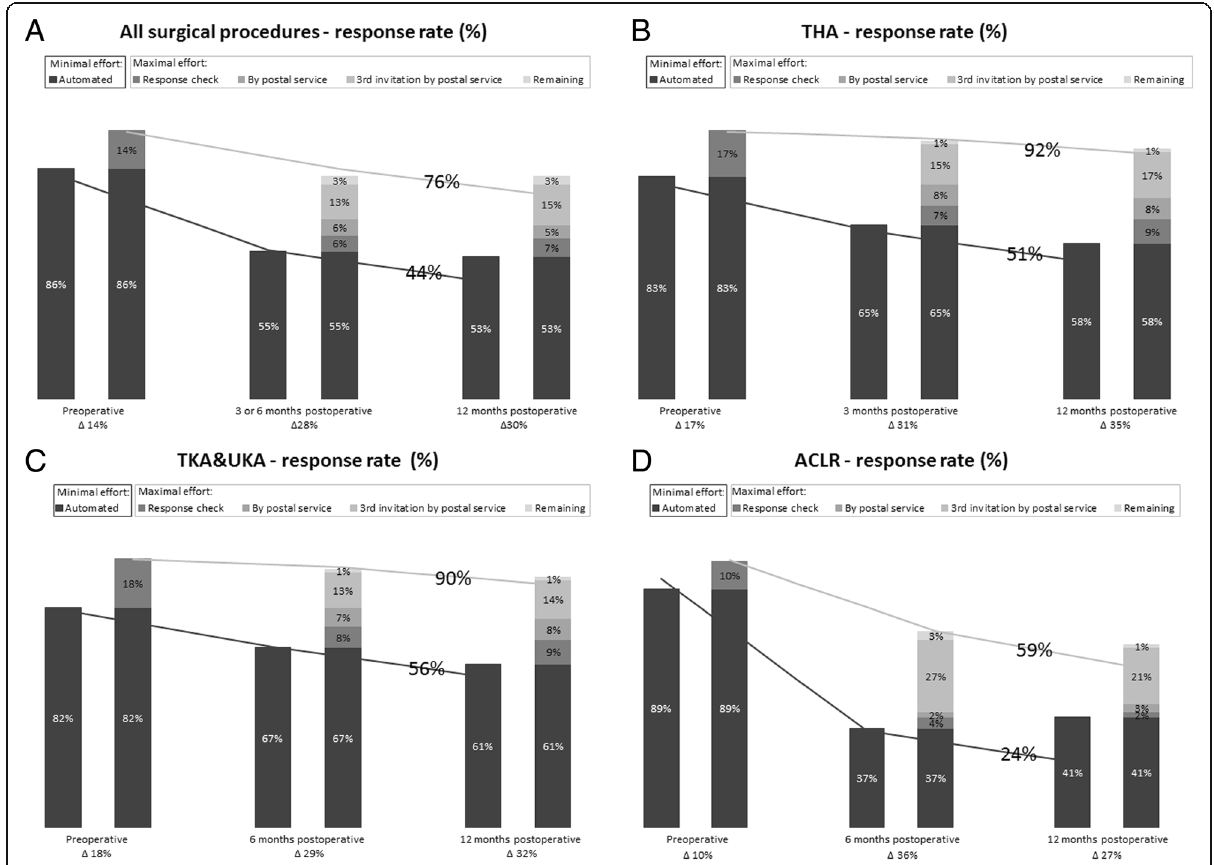
Fig. 2 Response rates (%) of PROs collection: minimal effort versus maximal effort. Represented for all surgical procedures ( a ) and the THA ( b ), TKA&UKA ( c ) and ACLR ( d ) subgroups. The line represents the response rate at all three time points. Note : PROs indicates patient-reported